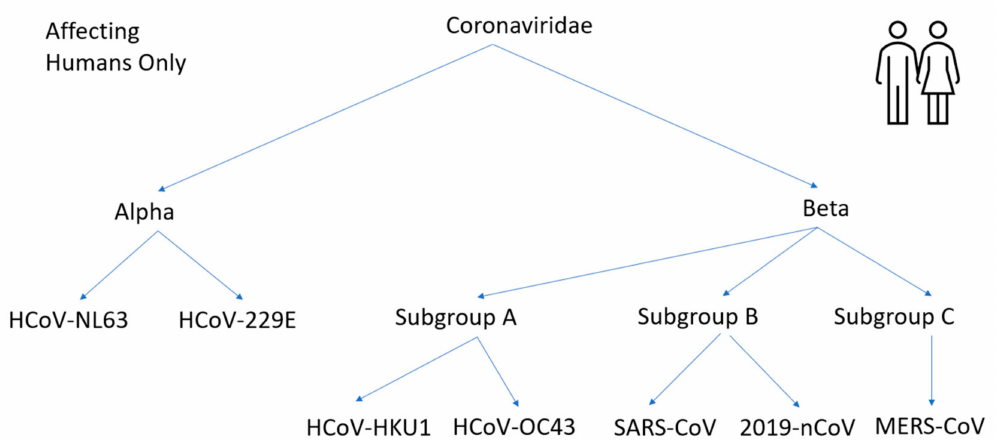
Figure 2. Coronaviruses affecting the Human